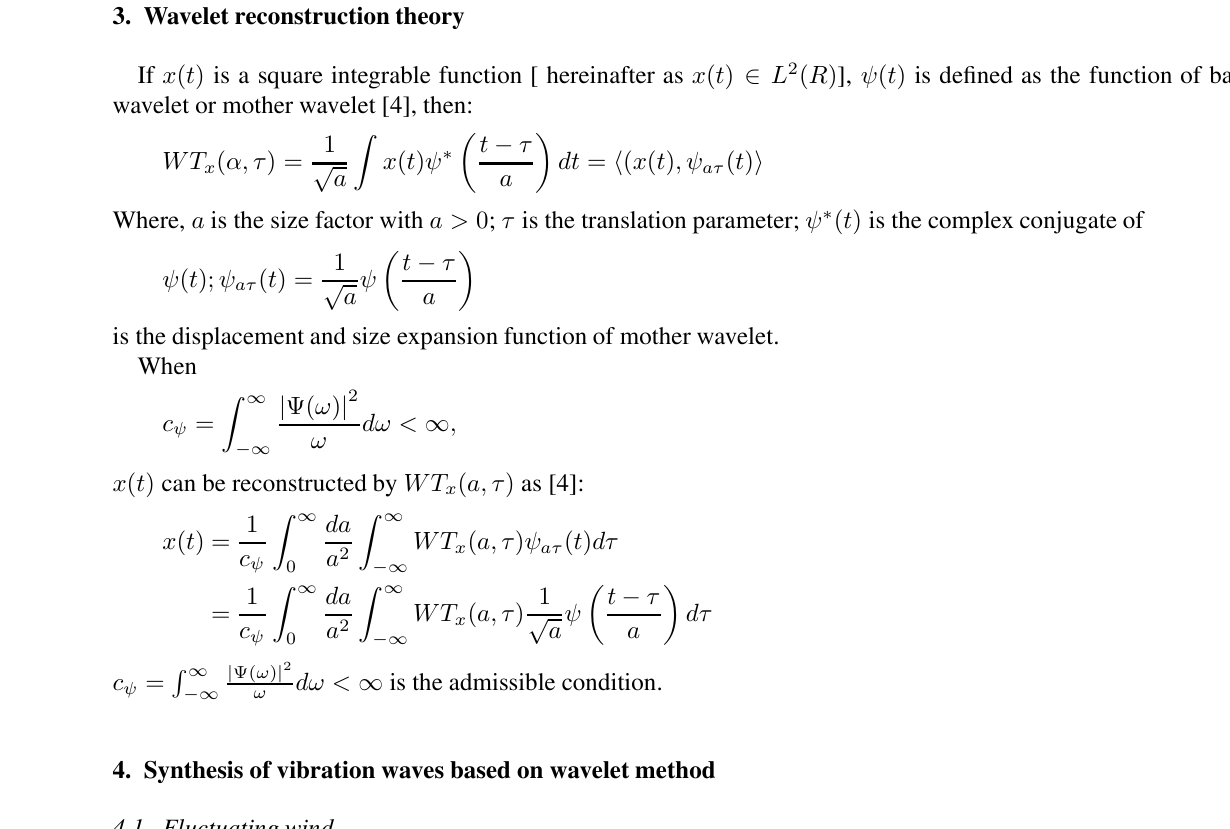
Fig. 1. Envelop function f